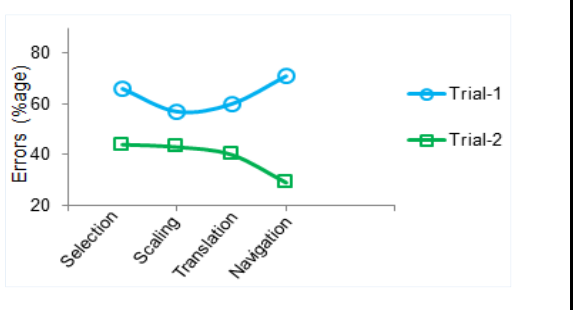
Fig. 17: The Percentage of errors occurred in Trial-1 and Tiral-2 interactions.